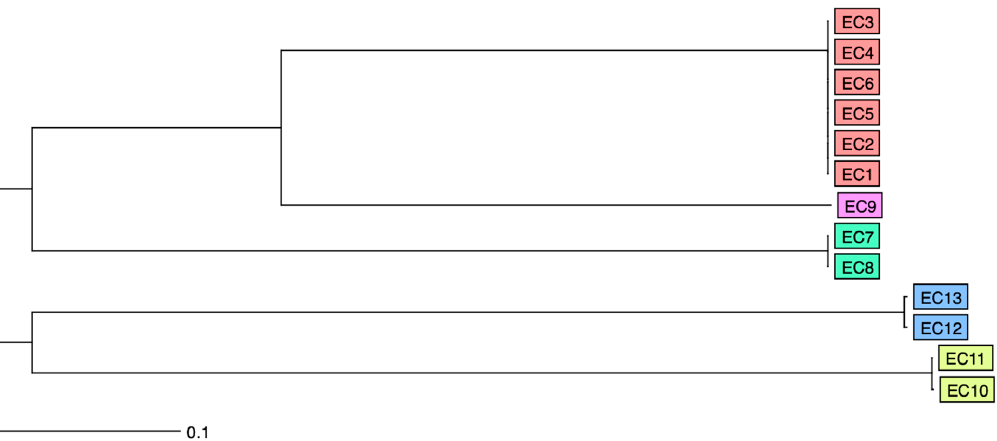
Figure 1. Neighbor-joining tree representing the whole-genome multi locus sequence type (wgMLST) analysis of the different E. coli isolates included in the study. Isolates belonging to the same clonal clusters are represented in the identical colors.